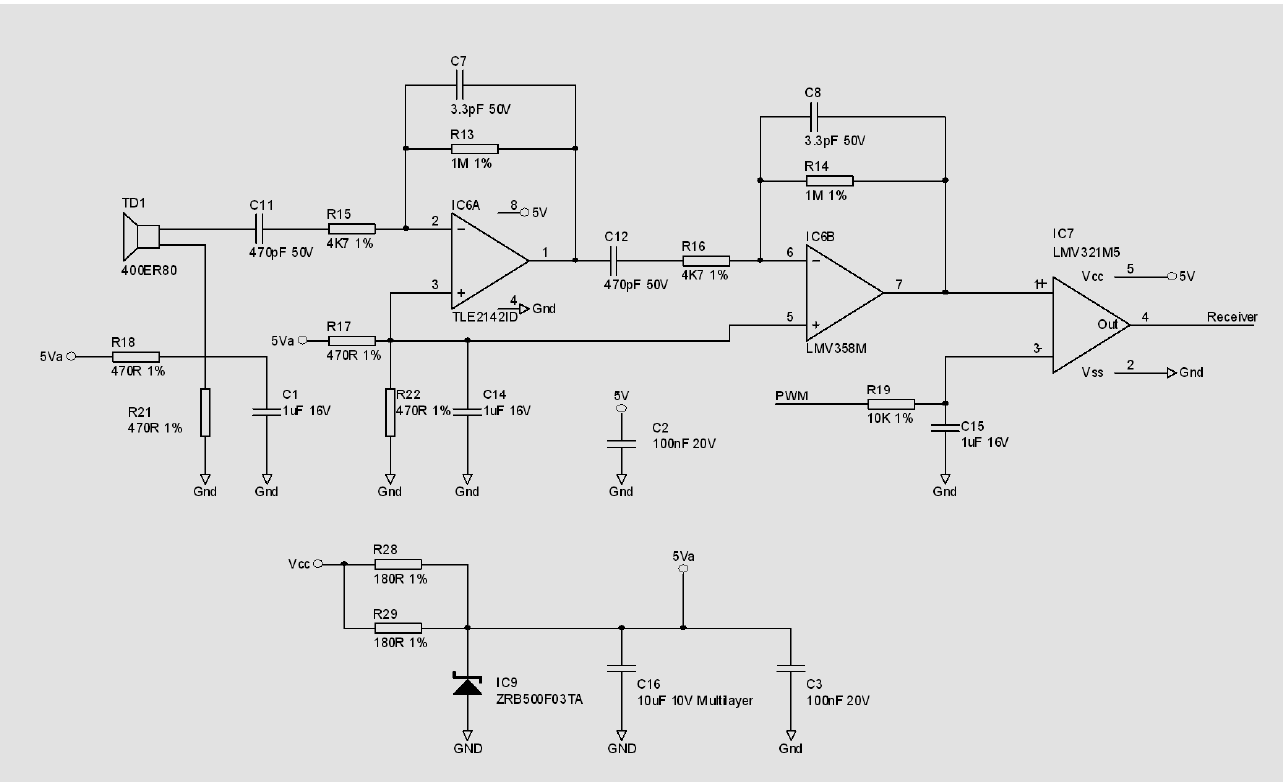
Figure 16 . Ultrasound